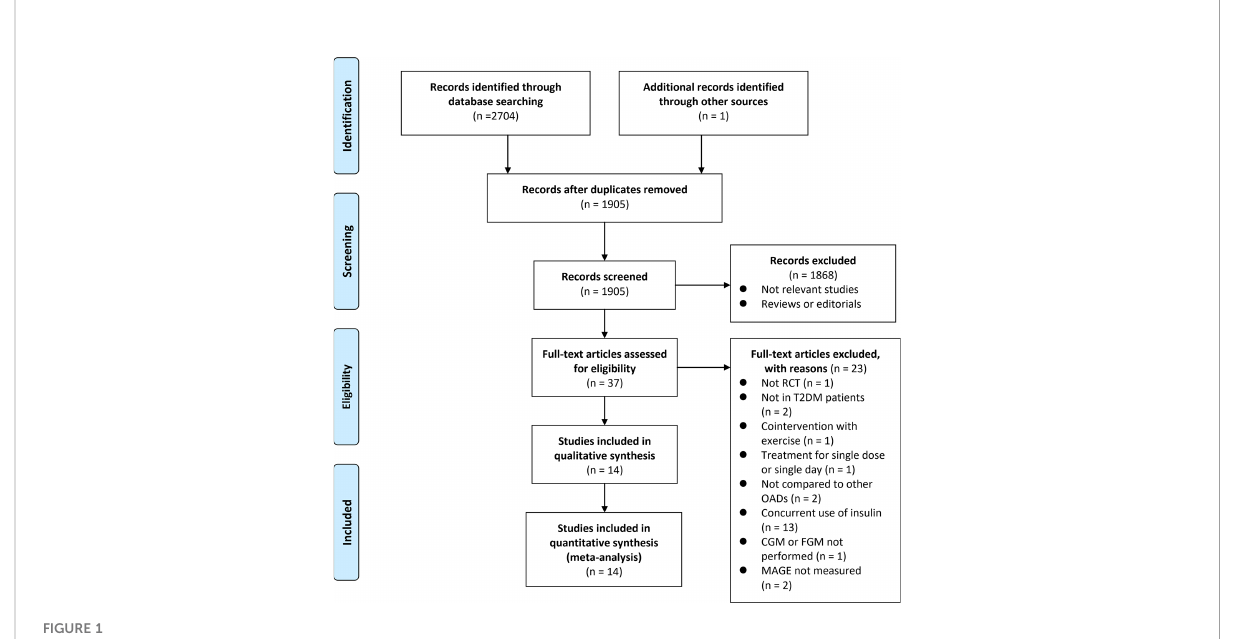
FIGURE 1 Flowchart of literature